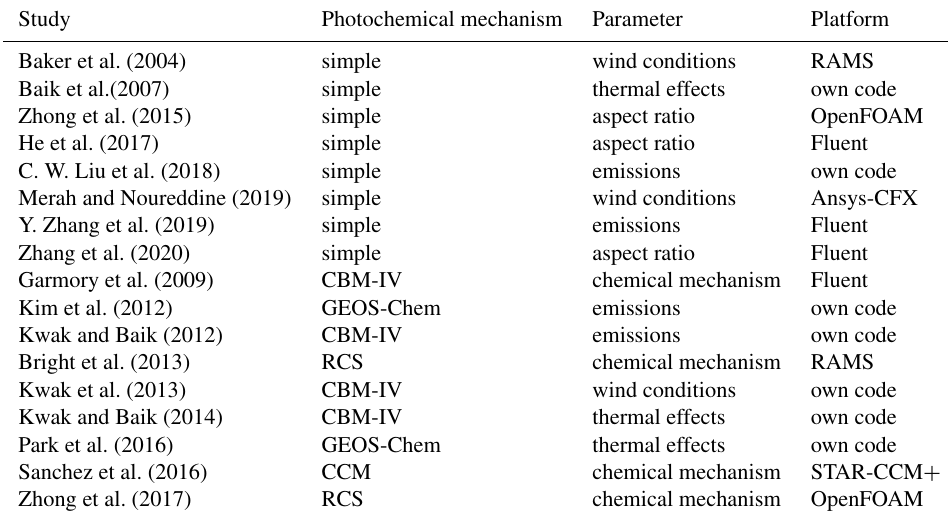
Table 1. Overview of the CFD studies with their photochemical mechanisms.